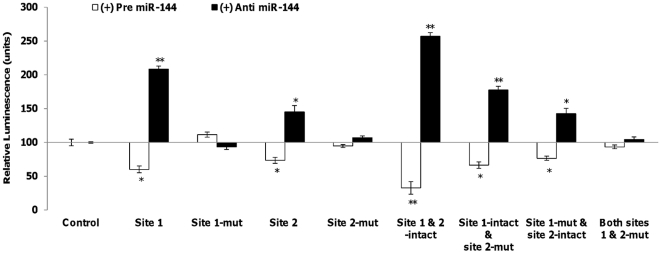
Direct inhibitory effect of miR-144 on IRS1.Dual luciferase assay. Quantitation of the effects of pre- or anti- miR-144 interaction with the 3′ UTR of IRS1. Binding sites of miR-144 at 3′UTR of IRS1 and mutated constructs of the binding sites are listed in Table S12. The plasmid constructs together with pre- or anti- miR-144 were co-transfected into HeLa cells. Luminescence for luciferase gene activity in treated samples (pre or anti miR-144) were obtained 48 hours post-transfection. Relative luminescence was obtained by normalizing the values against control plasmids, pMIR-REPORT™ without any 3′UTR insert. Data presented as mean ± SEM with n = 3. Fold change below one are expressed as the negative values. Statistically significant differences are tested at p<0.05 significance. *p<0.05, **p<0.01, ***p<0.001.